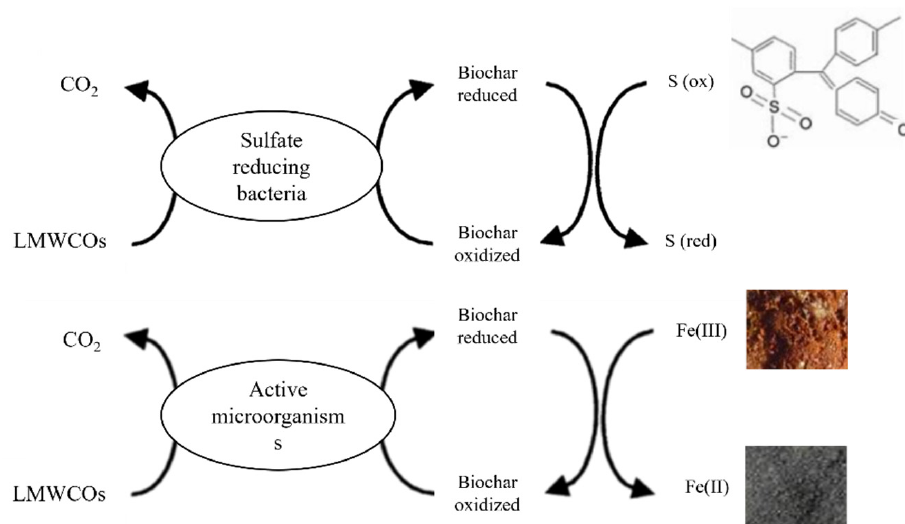
Figure 4. Hypotetical pathway of S and Fe reductions by electron shuttling via biochar.